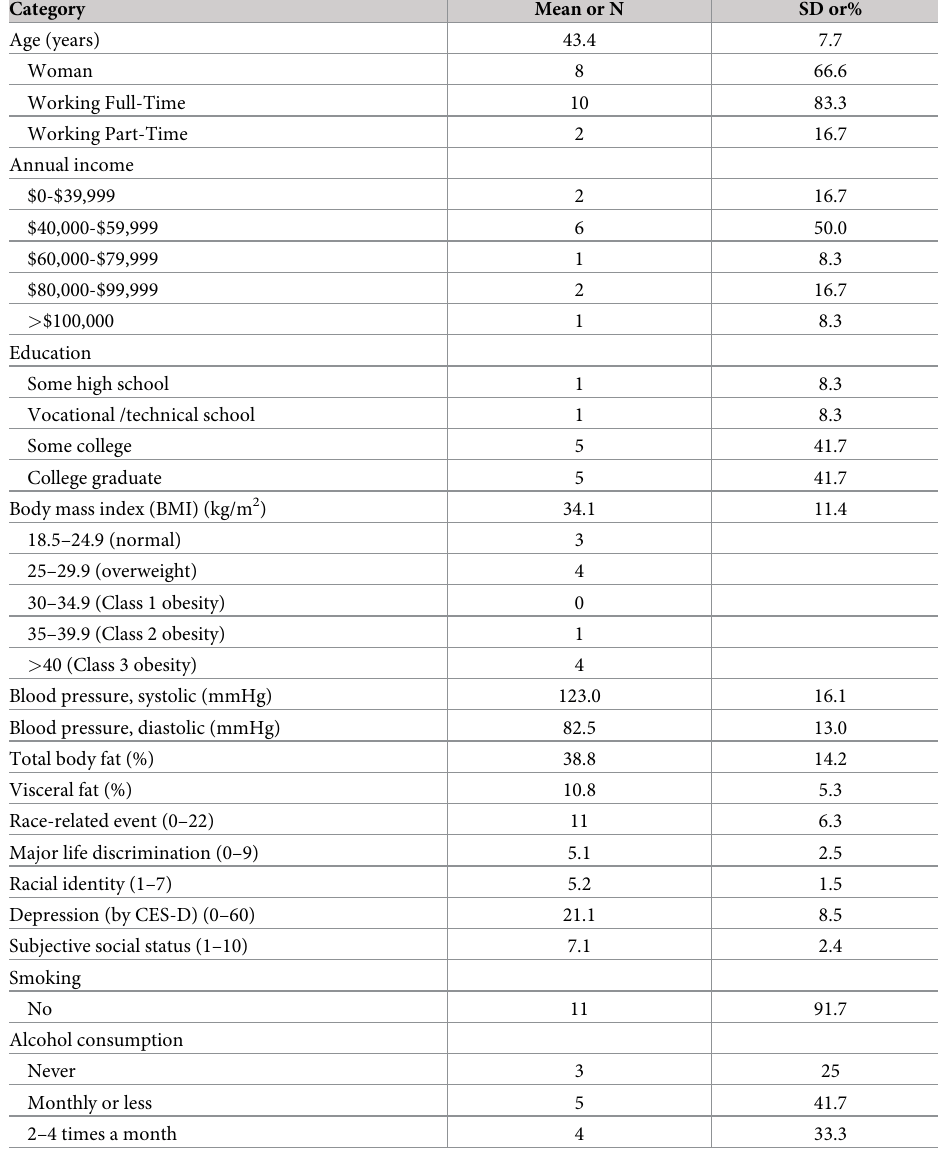
Table 1. Baseline characteristics of participants (N =